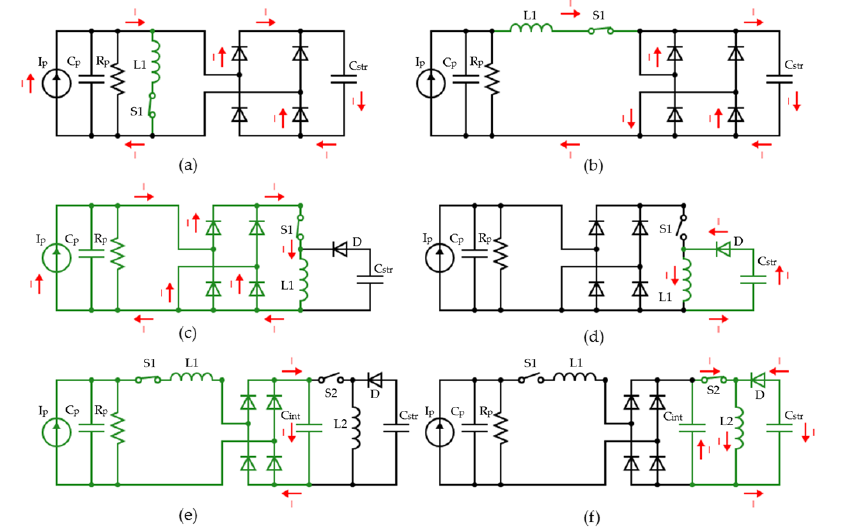
Figure 2. ( a ) Schematic of P-SSHI energy extraction interface, ( b ) schematic of S-SSHI energy ex- traction interface, ( c ) Schematic of SECE energy extraction interface when the switch S is closed, ( d ) schematic of SECE energy extraction interface when the switch S is open, ( e ) Schematic of D-SSHI energy extraction interface when the switch S1 is closed and S2 is opened, ( f ) schematic of D-SSHI energy extraction interface when the switch S1 is opened and S2 is closed